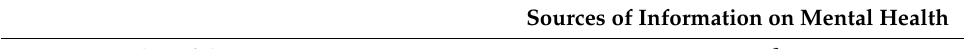
Table 1. Observed frequencies and expected frequencies (sources of information on mental health). Books and journals